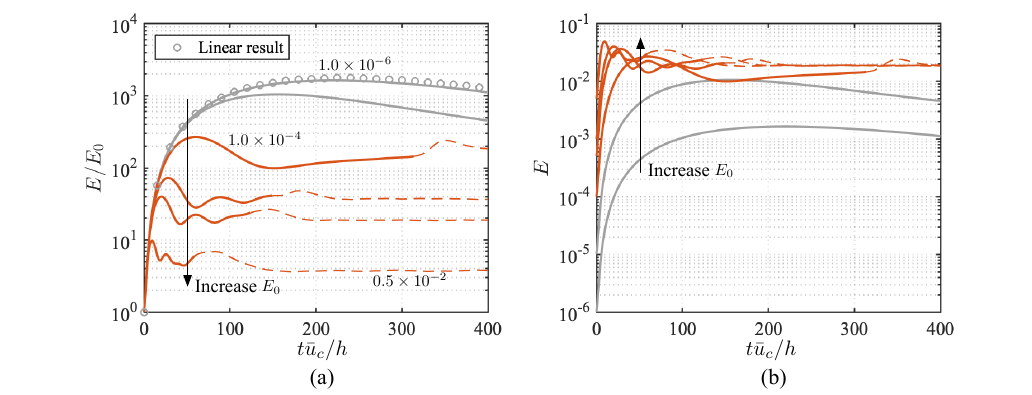
Figure 9. Time evolution of flow field to illustrate the laminar-to-turbulent transition process for the case ( α , β ) = ( 0,2 ) : The flow is initialized by optimal disturbance with kinetic energy density of ( h / ¯ u c ) 2 = 0.0004) colored by streamwise vorticity E 0 = 1.0 10 − 4 . Iso-surfaces of -criterion ( × Q Q ˜ ω x h / ¯ u c are visualized.